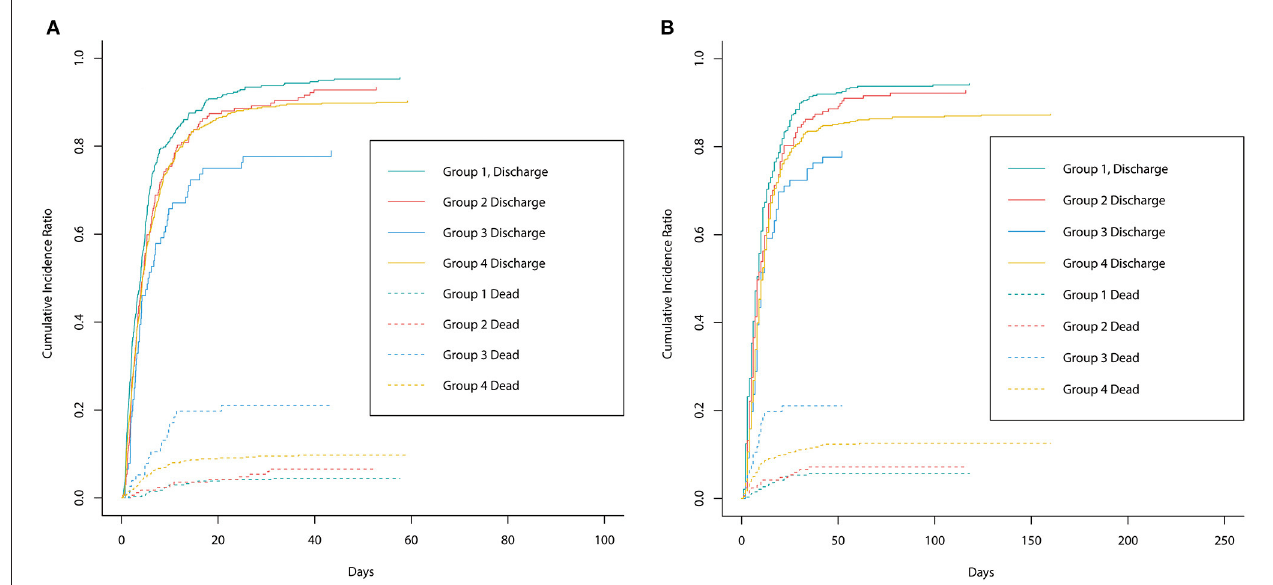
FIGURE 3 | The cumulative incidence curve between groups for ICU discharge and hospital discharge. The solid line represented the cumulative incidence ratio (CIR) of alive discharged patients while the dashed line represented the CIR of dead discharged patients (competing for risk). (A) Represented the cumulative incidence curve for ICU discharge between groups. (B) Represented the cumulative incidence curve for hospital discharge between groups.